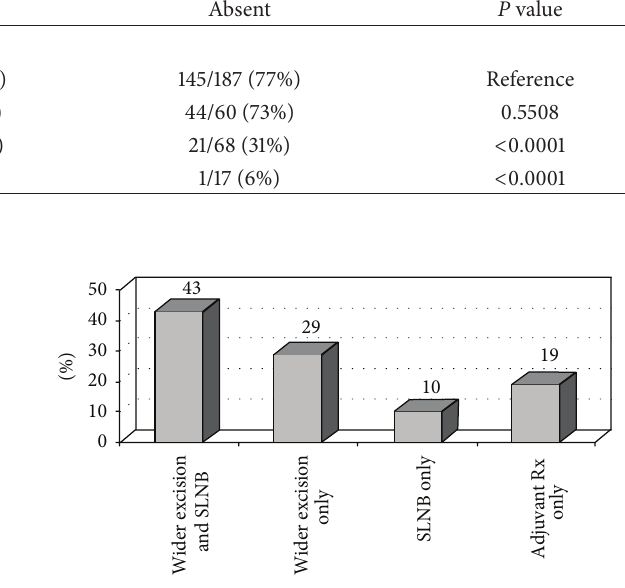
Figure 2: Changes in Treatment Recommendations After Wide Local Excision. Abbreviations: SLNB = sentinel lymph node biopsy; Rx =